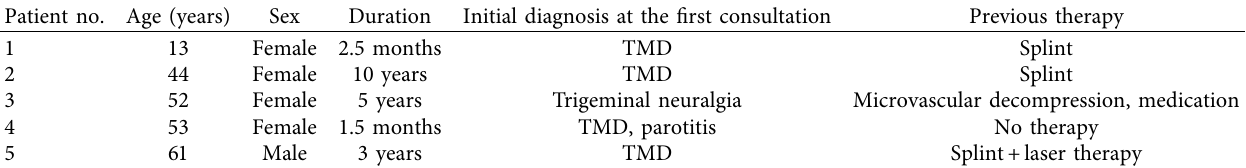
Table 1: Characteristics of patients with idiopathic first bite syndrome.